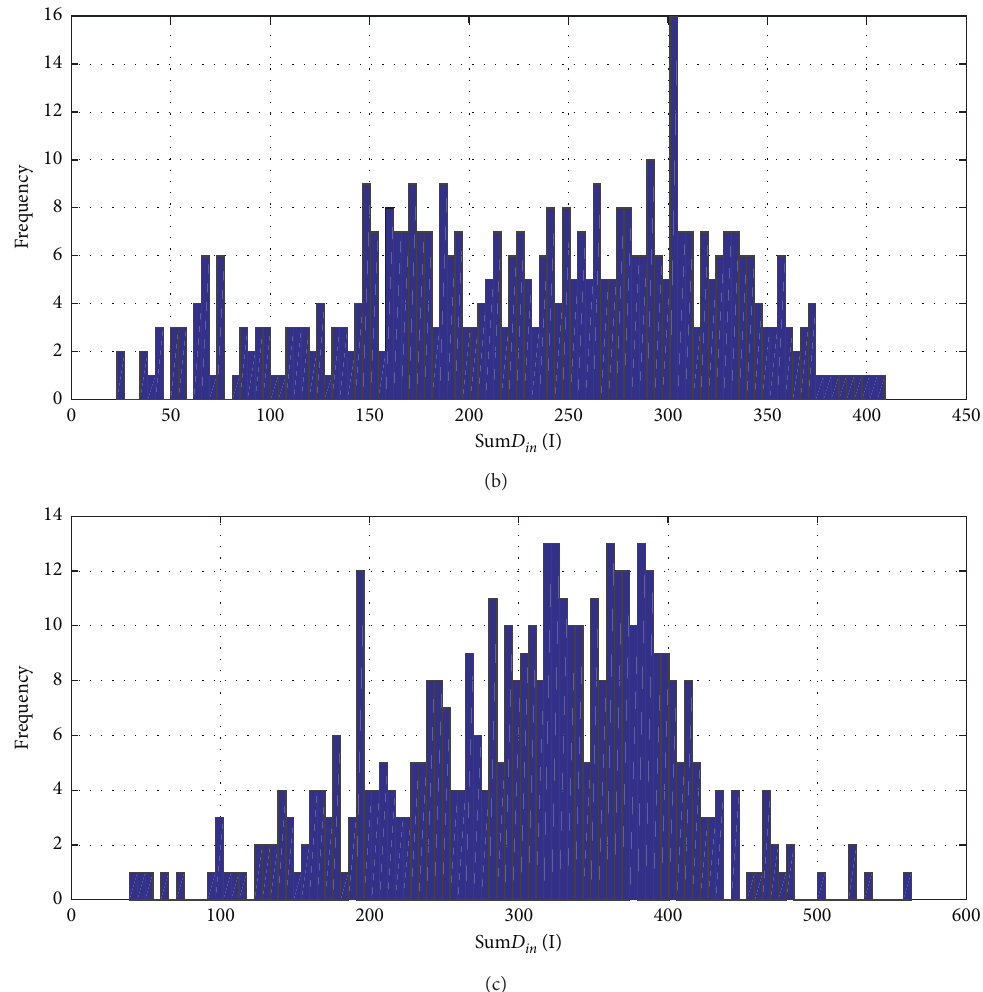
Figure 12: Distributions of Sum D ( i ) for different time periods: (a) morning peak time; (b) nonpeak time; (c) evening peak in